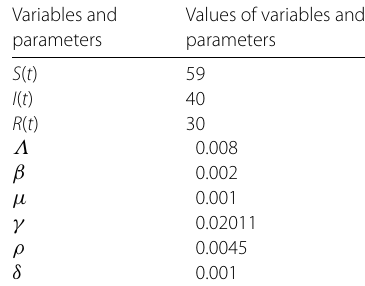
Table 2 Values of variables and parameters for numerical solution